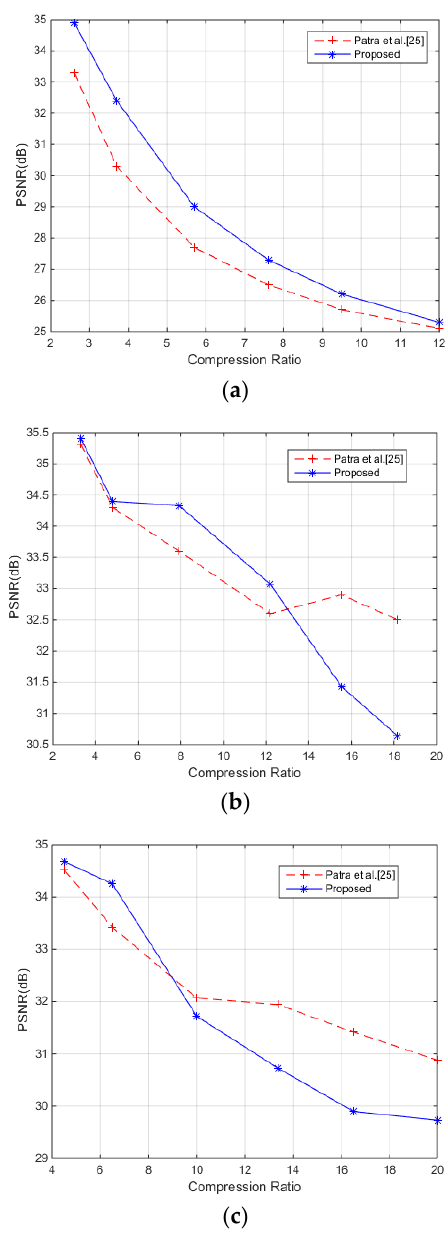
Figure 7. PSNR vs. Compression ratio on ( a ) Mandrill; ( b ) Lena; ( c ) Boat